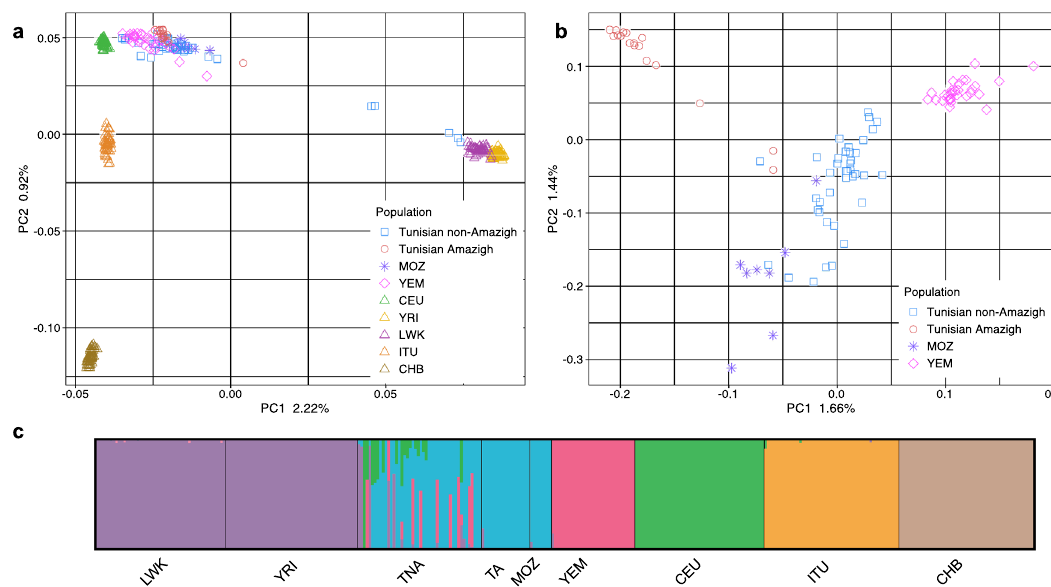
Figure 1. Principal component analysis and ADMIXTURE analysis for K = 6. ( a ) Principal component analysis of exome variants in Tunisian samples together with a panel of surrounding and other worldwide populations. ( b ) Principal component analysis of Tunisian samples together with Mozabite and Yemeni samples, excluding nine outlier individuals in A. ( c ) ADMIXTURE analysis (K = 6) of North African samples together with a panel of surrounding and other worldwide populations. Population abbreviations stand for Tunisian Amazigh (TA), Tunisian non-Amazigh (TNA), Mozabite (MOZ), Yemeni (YEM), Yoruba (YRI), Luhya (LWK), Utah residents (CEPH) with Northern and Western European ancestry (CEU), Han Chinese in Beijing (CHB) and Indian Telugu in the UK (ITU).